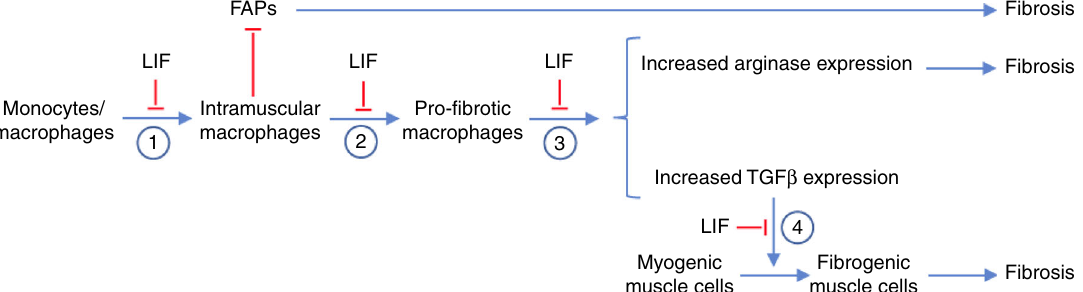
Fig. 10 Potential immunomodulatory and anti- fi brotic actions of LIF expressed by the CD11b/LIF transgene in muscular dystrophy. (1) LIF can serve an immunomodulatory role by reducing the expression of Ccl2 in macrophages, which is associated with reduced recruitment of monocytes/macrophages into dystrophic muscle. (2) LIF can serve an immunomodulatory role by reducing the activation of monocytes/macrophages to a CD163 + , M2-biased phenotype that can increase fi brosis of dystrophic muscle. (3) LIF can reduce the expression of the pro- fi brotic molecules Arg1 and Tgfb1 in macrophages. (4) LIF can reduce the TGF β 1-mediated induction of pro- fi brotic genes in muscle cells, including Ctgf and